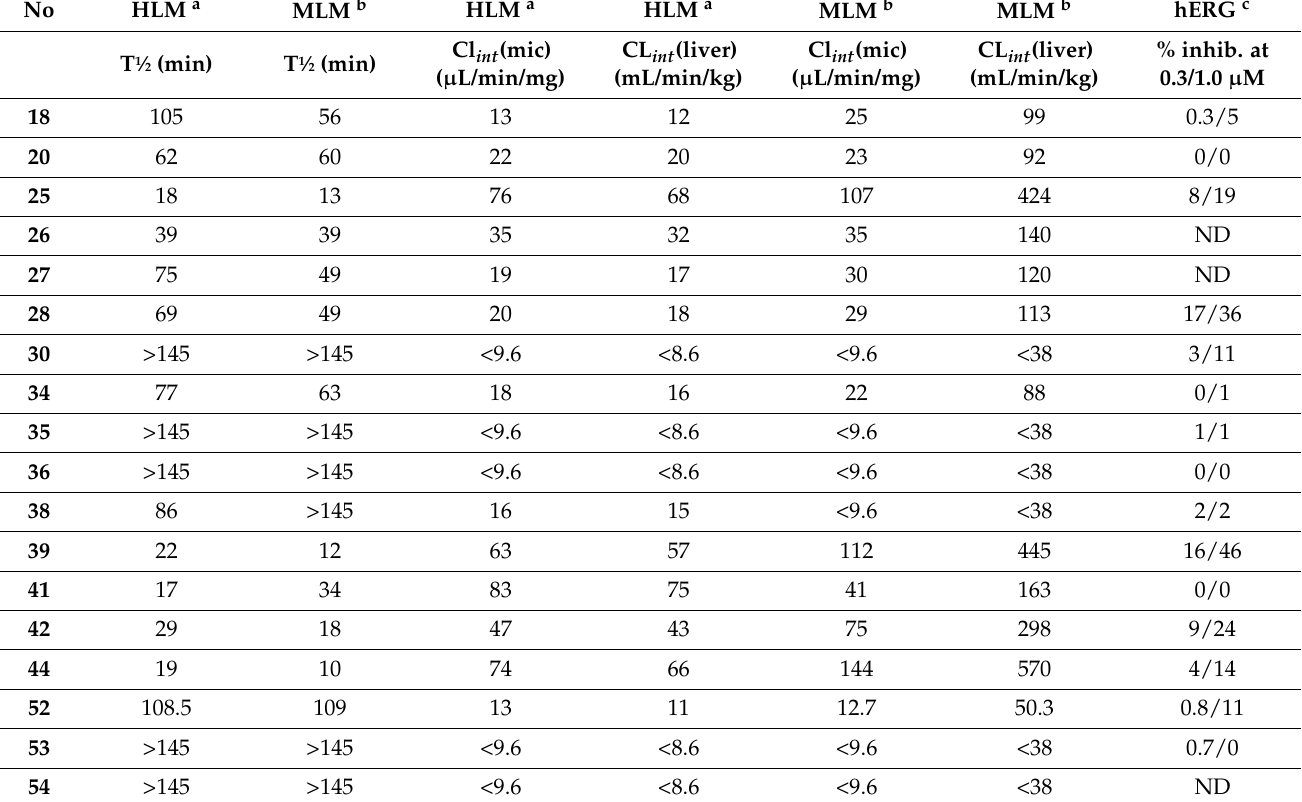
Table 4. Microsomal stability and hERG inhibitory properties for the selected